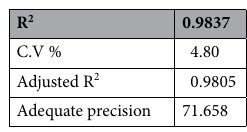
Table 3. Statistical results of the ANOVA for the reduced quadratic model.